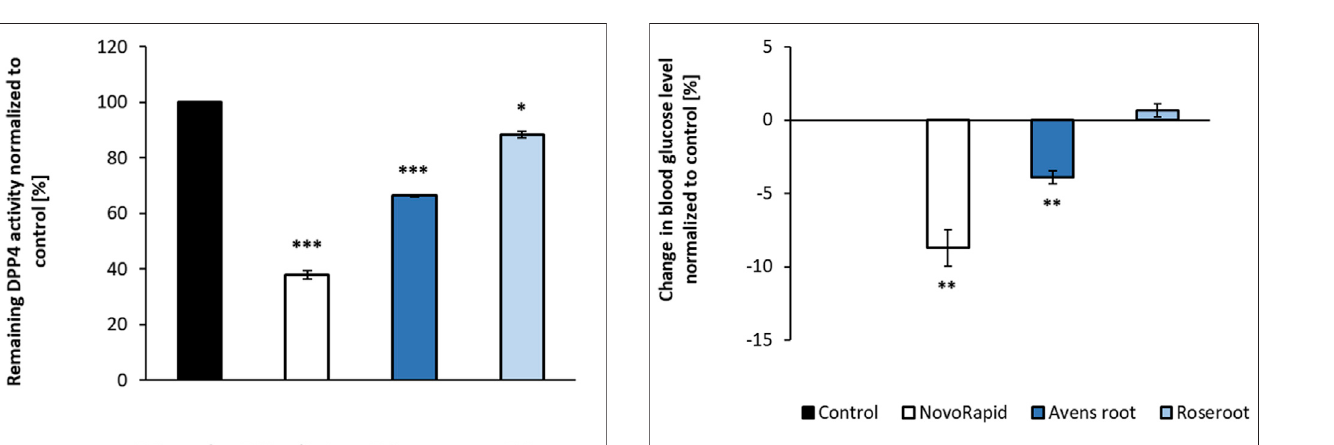
FIGURE5| In fl uenceofrootextractsonbloodglucoselevels in-ovo .The air compartment of 11 day old hen ’ s eggs were treated with ddH 2 O (control) or the indicated substances (NovoRapid: 3 U/ml; root extracts: 1:17) dissolvedinddH 2 O(300 µlvolume)forupto60 min.Afterthat,asuitable blood vessel of the chicken embryo was dissected for blood collection. Blood glucose levels were determined with a blood glucose meter. Control (n (cid:2) 4); NovoRapid (n (cid:2) 5); avens root extract (n (cid:2) 4); roseroot extract (n (cid:2) 4). Error bars indicate the standard error of the mean. ** p < 0.01, with a signi fi cant decrease with respect to control.